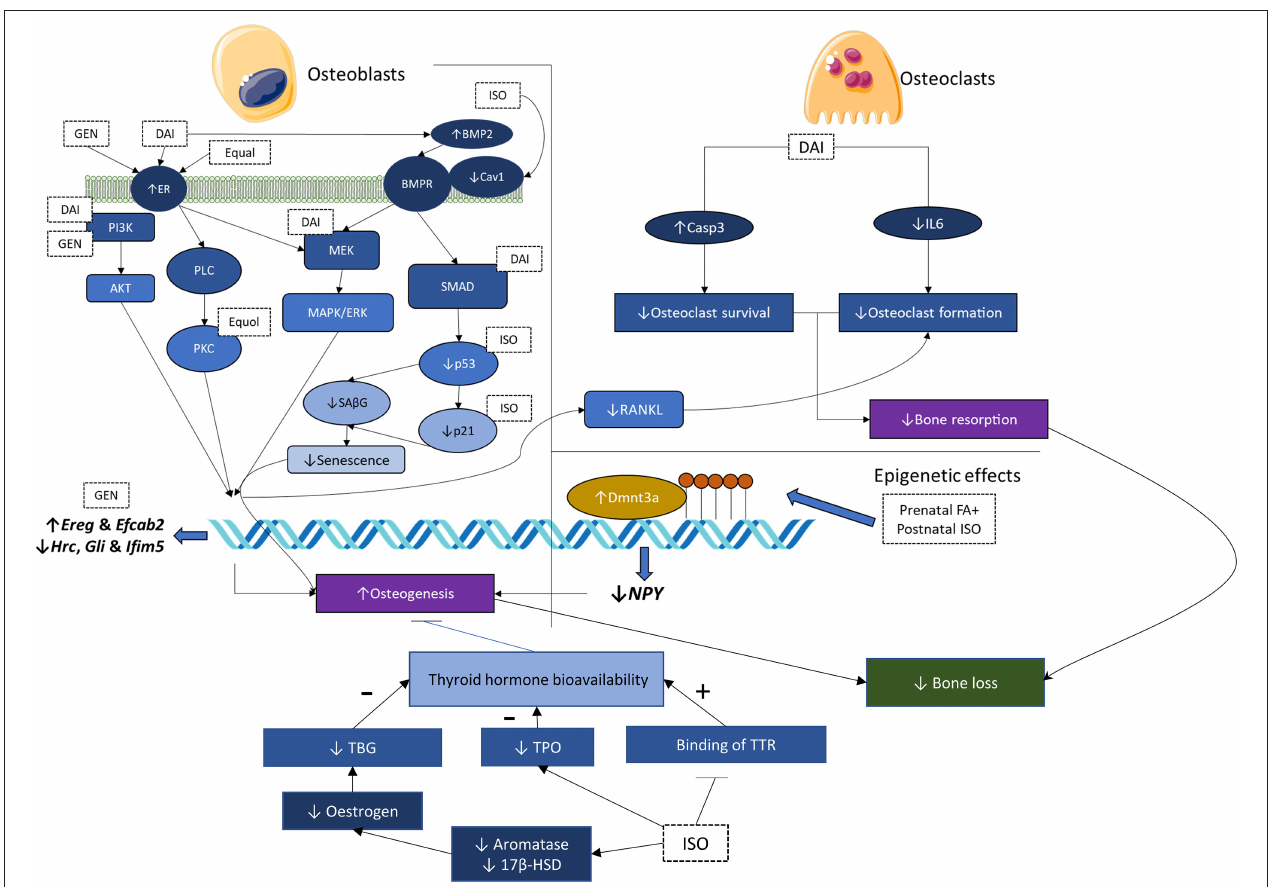
FIGURE 2 | Mechanisms of action of soy isoflavones and soy protein isolates. 17- β -HSD, 17- β -hydroxysteroid dehydrogenase; BMP-2, bone morphogenetic protein-2; Cav1, caveolin-1; DAI, daidzein; Dnmt3a, DNA methyltransferase 3a; ER, estrogen receptor; ER- α / β , estrogen receptor- α / β ; FA, folic acid; GEN, genistein; IL-6, interleukine-6; ISO, isoflavone mixture; MAPK, mitogen-activated protein kinase; MEK/ERK, MAPK kinase/extracellular-regulated kinase; NPY, neuropeptide Y; PI3K/Akt, phosphoinositide 3-kinase/protein kinase B; PKC, protein kinase C; PLC, phospholipase C; RANKL, receptor activator of nuclear factor kappa-B ligand; SA β G, senescence-associated beta-galactosidase; T4, thyroxine; TBG, thyroxine-binding globulin; TH, thyroid hormone; TPO, thyroid peroxidase; TTR,